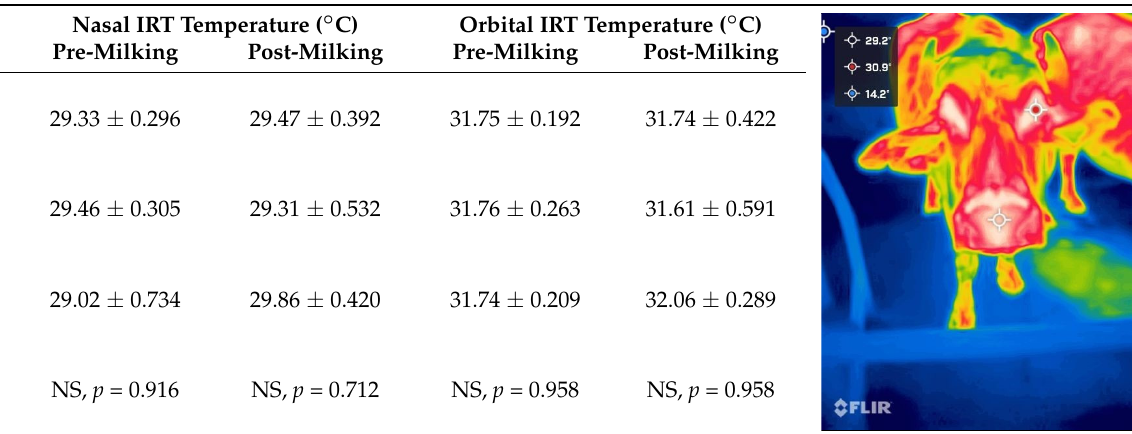
Table 5. Mean ± SEM for pre- and post-milking infrared thermography (IRT) data at orbital and nasal regions, in nervous and calm buffalo cows.